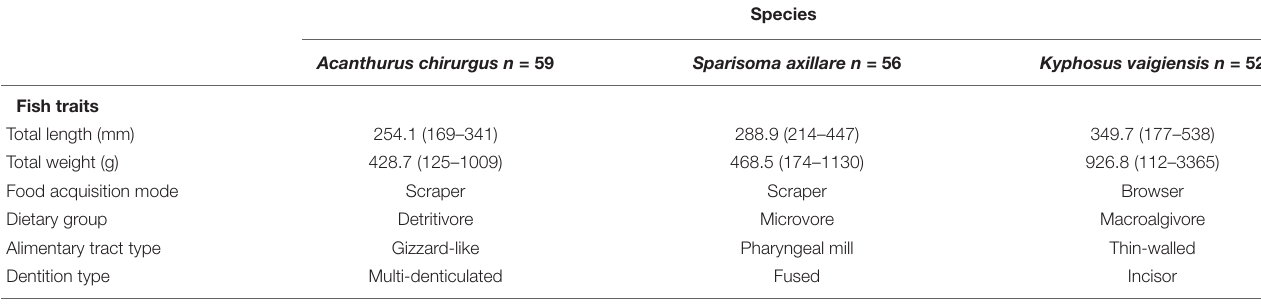
TABLE 1 | Total ( n ) number of specimens, mean (range) species’ total length (TL) and weight, and ecological traits classification for each study species.